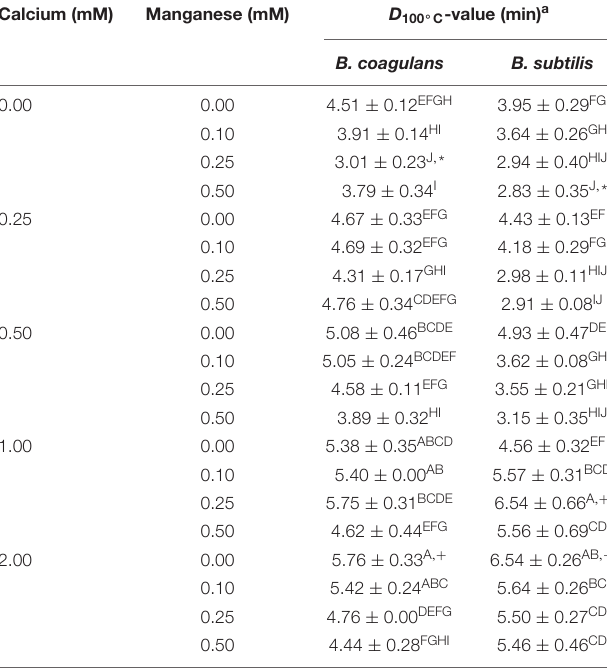
TABLE 2 | Statistical differences in heat resistance of B. coagulans and B. subtilis spores as affected by diverse concentrations of calcium and manganese. Calcium